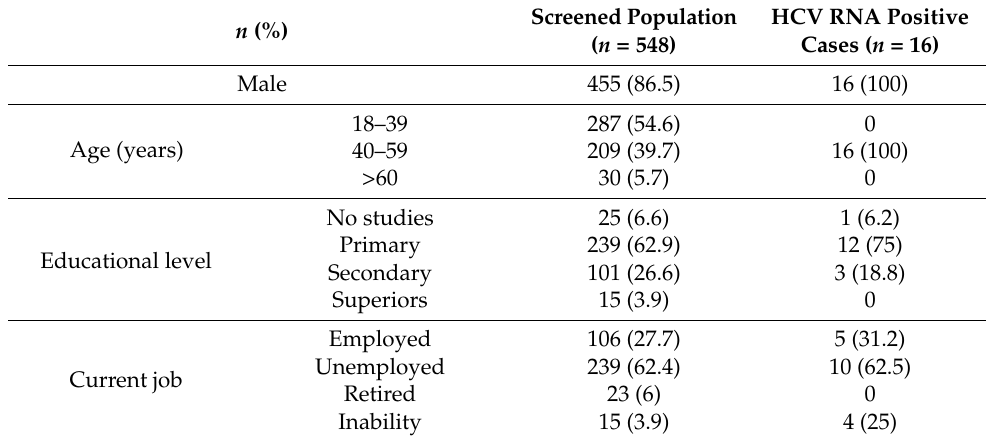
Figure 3. Flow chart of the study. SVR: sustained virological response (negative HCV RNA 12 weeks after the end of treatment). PPR: per-protocol response. ITR: intention to treat response. Table 1. Main features of the study population.